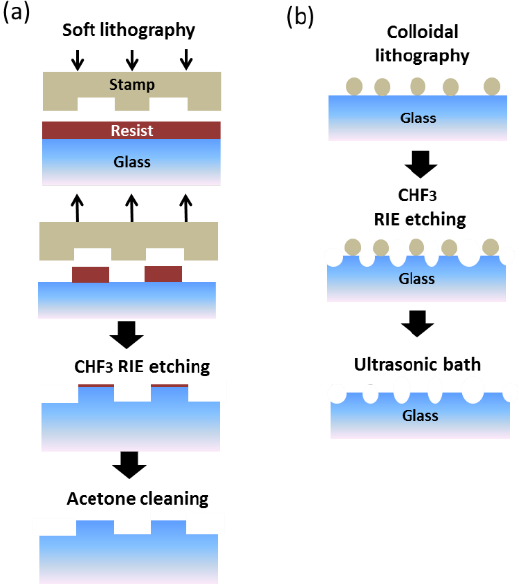
Figure 1. Fabrication processes. ( a ) Soft lithography for order samples ( b ) Colloidal lithography for disorder